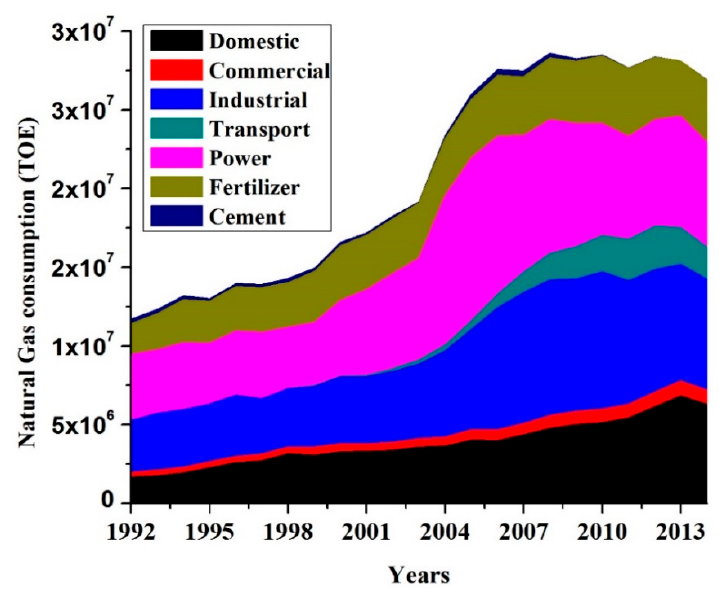
Figure 5. Natural gas consumption across various sectors (1992–2014).